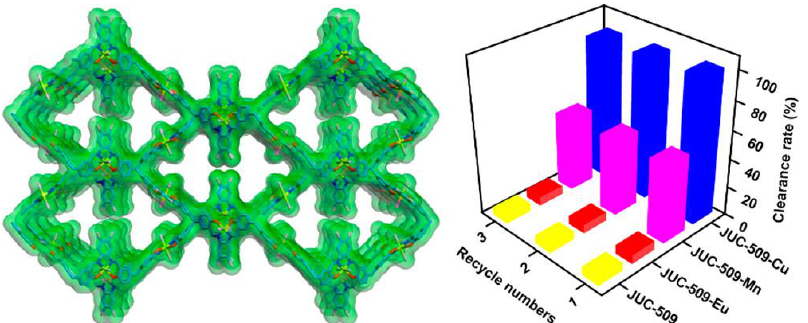
Figure 18. The 3D salphen-based COFs as catalytic antioxidants. Reprinted (adapted) with permission from [27]. Copyright {2019} American Chemical Society.